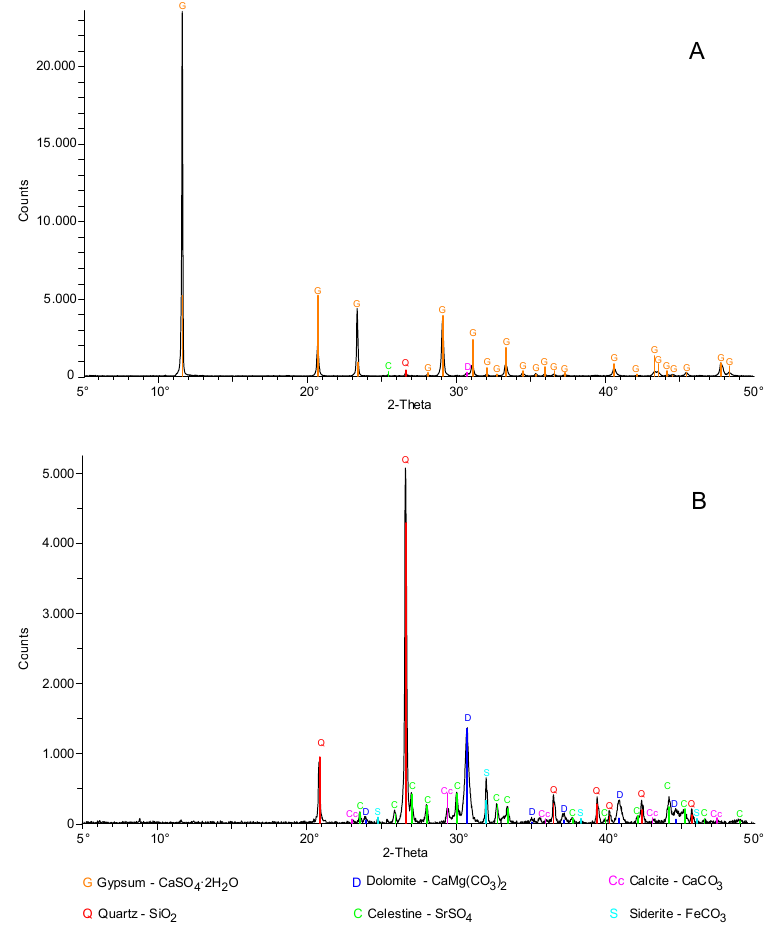
Figure 2. A ) Mineralogical composition of sample before dissolution, XRD determination; B ) Figure mineralogical composition of sample after dissolution with ammonium acetate.